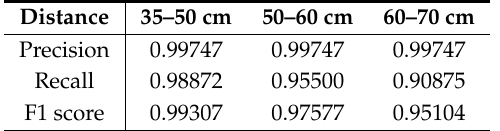
Table 4. Experiment results of total precision error, total recall error, and total F1